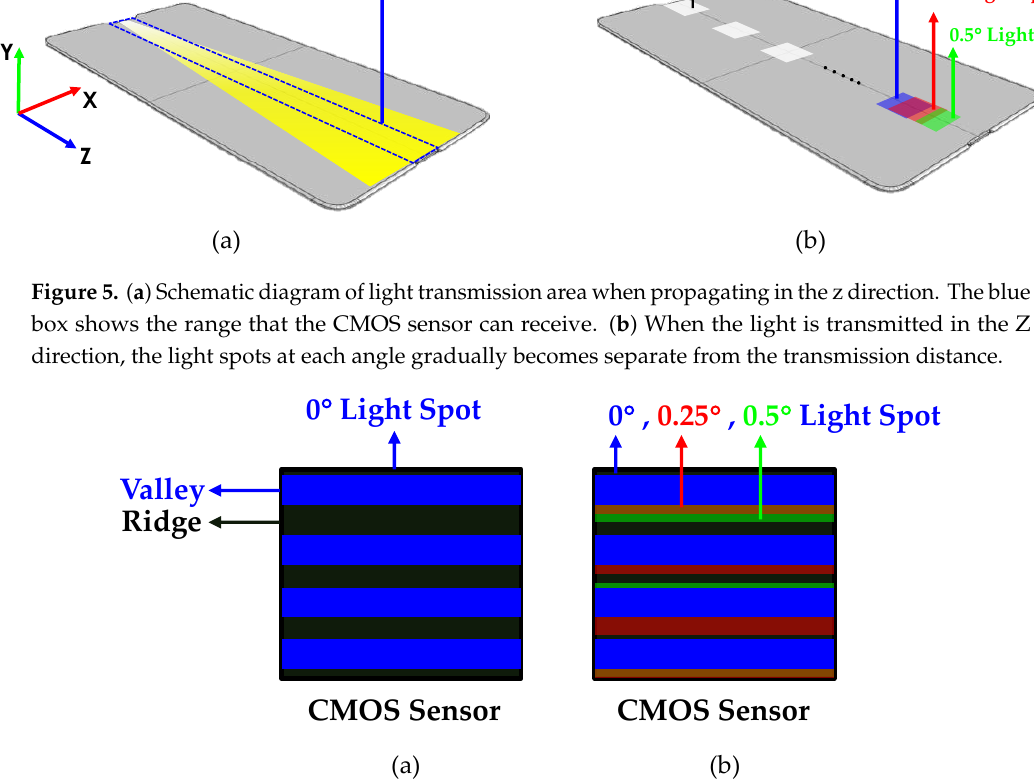
Figure 6. ( a ) Schematic diagram of the energy distribution on the CMOS sensor after absorption of 0 ◦ light from the fingerprint ridge signal. ( b ) Schematic diagram of the energy on the CMOS sensor after absorption of the 0, 0.25, and 0.5 degree light from the fingerprint ridge signal. Because the reflection frequency of each angle is di ff erent, the gray level of the ridge changes, resulting in a decrease in contrast.